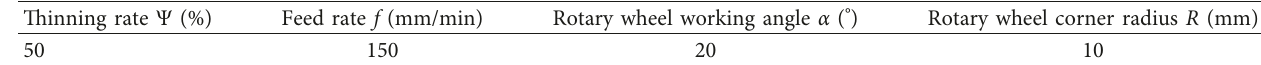
Figure 20: Cracks caused by inappropriate rotary wheel corner radius. (a) Corner radius of 8mm and (b) corner radius of 10mm. Table 10: Verified spinning process